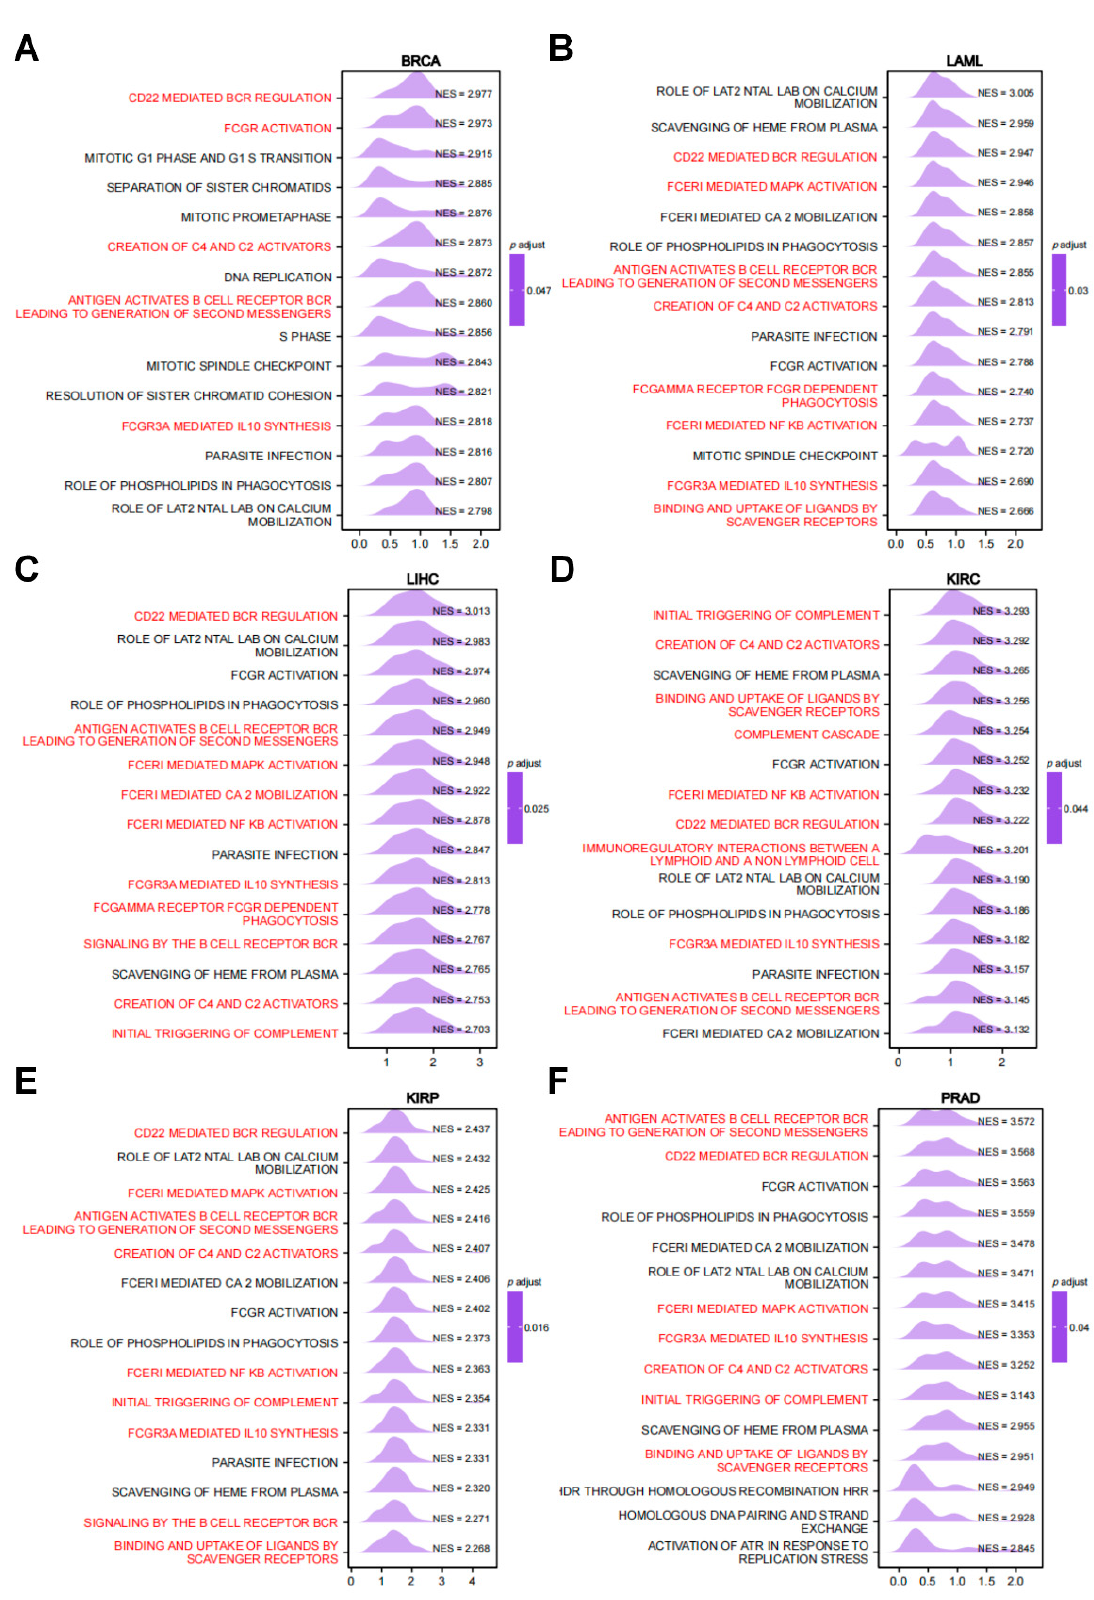
Figure 6. GSEA of RRM2 in pan-cancer. ( A – F ) The top 15 significant pathways of RRM2 GSEA analysis results across the indicated tumor types (Red color represents immune-related pathways).